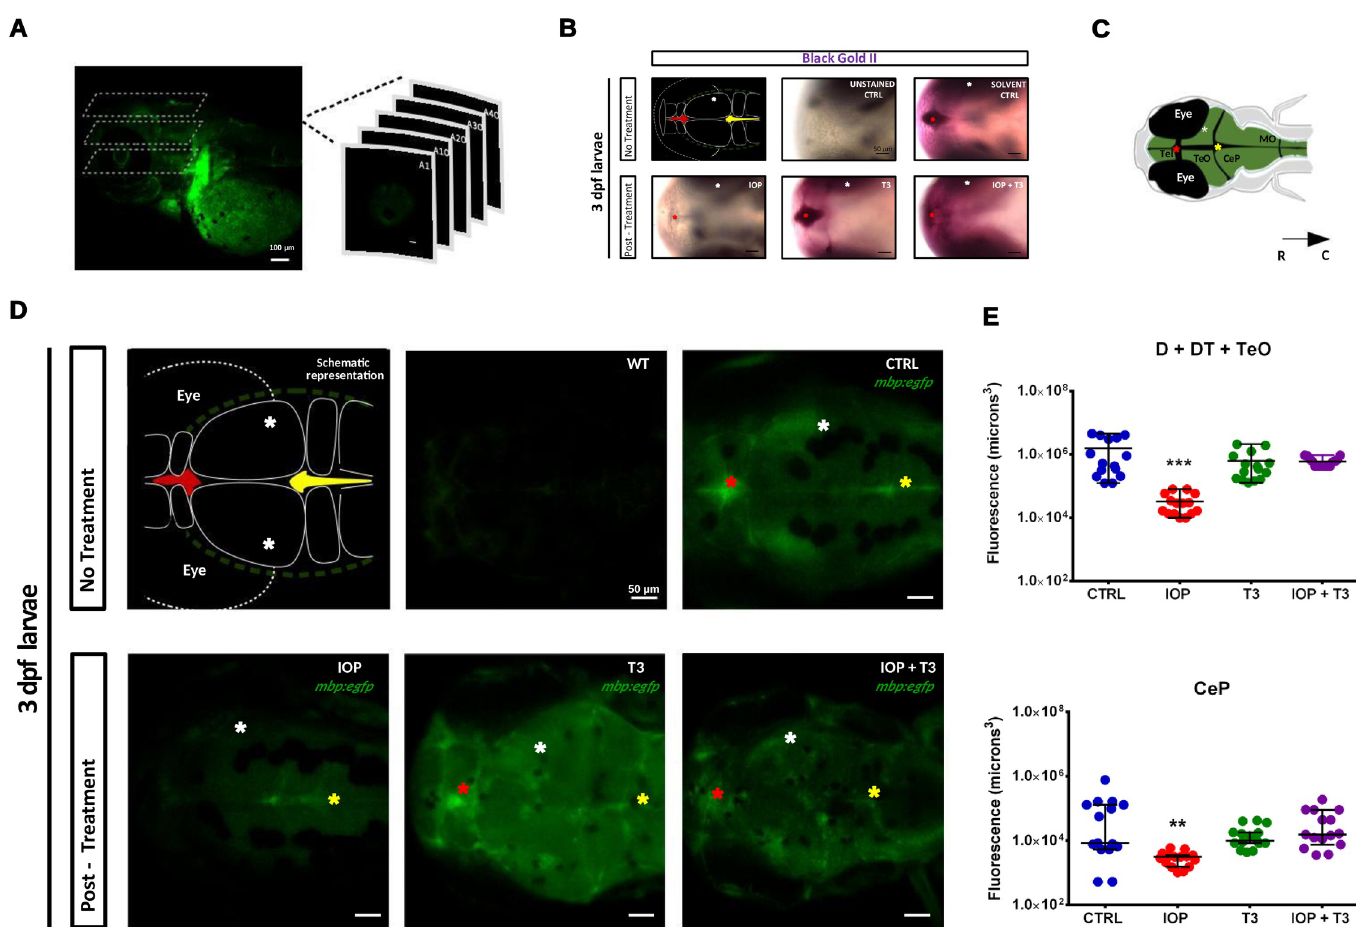
Fig 5. IOP and T3 rescue treatment in mbp : egfp transgenic zebrafish larvae at 3 dpf. (A) Lateral scan of the head using confocal microscopy and generating multiple 3D optical sections; scale bar: 100 μ m. (B) Representative photomicrograph of zebrafish larvae with dorsal view and R-C orientation, whole-mount Black-Gold II staining in D, DT and at 3 dpf (wild-type, CTRL, IOP, T3 and IOP + T3). scale bar: 50 μ m. ( C ) Schematic drawing with dorsal view of the head; the asterisks represent signal in the habenula and between the telencephalon (Tel) and tectum opticum (TeO) (red); signal within the TeO (white) and signal in the dorsal Tectum and between TeO and cerebellar plate (CeP) (yellow). The black arrow represents the orientation of the larvae, rostral-caudal (R-C). ( D ) The images are the representation of the maximum intensity projection of the entire set of Z-stacks: uninjected CTRL (WT), CTRL, larvae treated with IOP 0.5 μ M, T3 10 nM or IOP 0.5 μ M + T3 10 nM; scale bar: 50 μ m. (E) Graphs depicting the volume of the myelinated area in voxels, Data are shown as individual values and mean ± SEM (approximately n = 15 larvae/group). Statistical analysis was performed with one-way ANOVA coupled with Tukey’s multiple comparison test with respect to the control group. �� p < 0.01 and ��� p < 0.001.